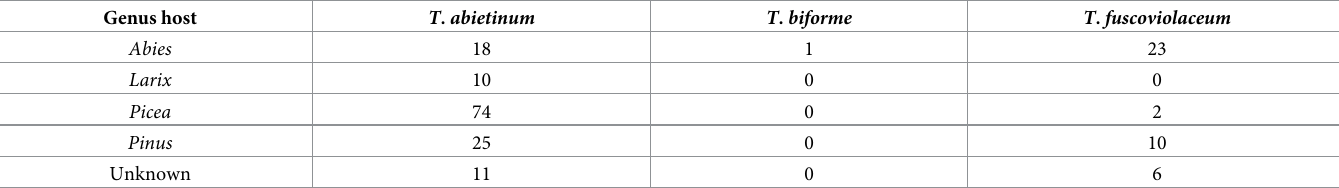
Table 2. Distribution of host trees for Trichaptum